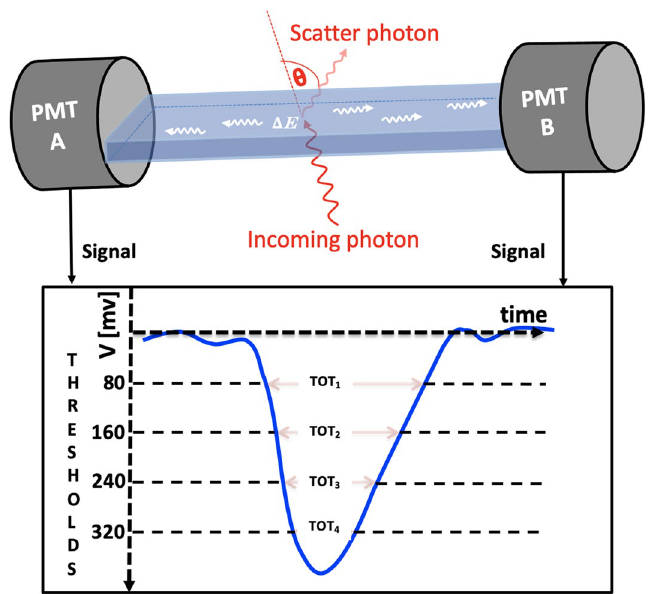
Fig. 2 Illustration of deposition of energy by incident photons in the scintillator and obtaining the analog signal from both PMTs (A, B). The signals from each side are sampled at four equally spaced thresholds with minimum values of 80 mV and maximum values of 320 mV. The sum of TOT i , where i is the number of thresholds, gives the measure of energy deposition calculated by Eq.